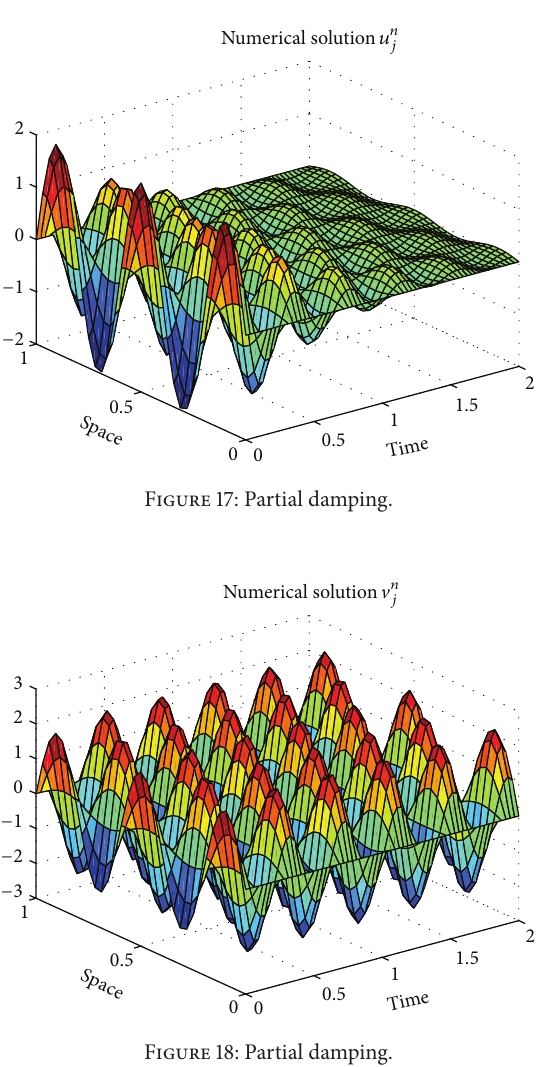
Figure 18: Partial